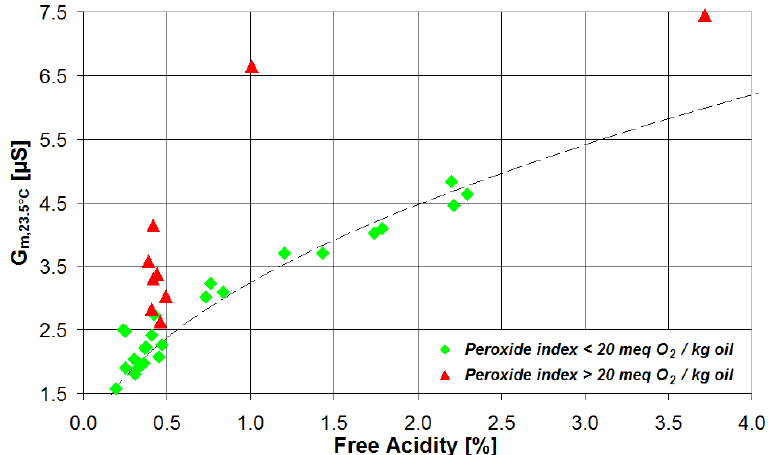
Figure 5. Scatter plot of the emulsion electrical conductance measured at 23.5 °C using the HAS reagent vs. free acidity for two different subsets of olive oil samples (fresh samples and oxidized samples).